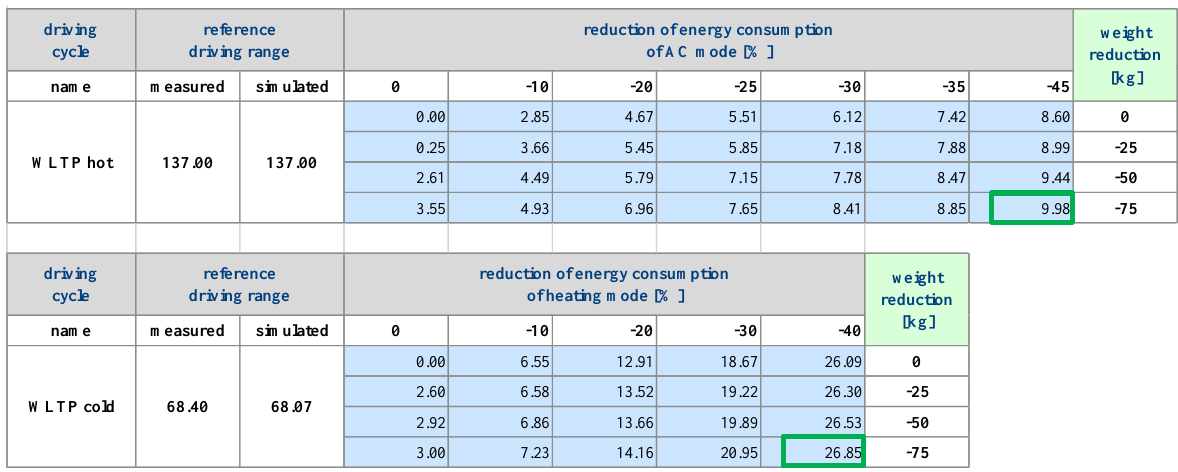
Table 2. Expected increase of the driving range (cp. blue cells, in percent) under different driving conditions